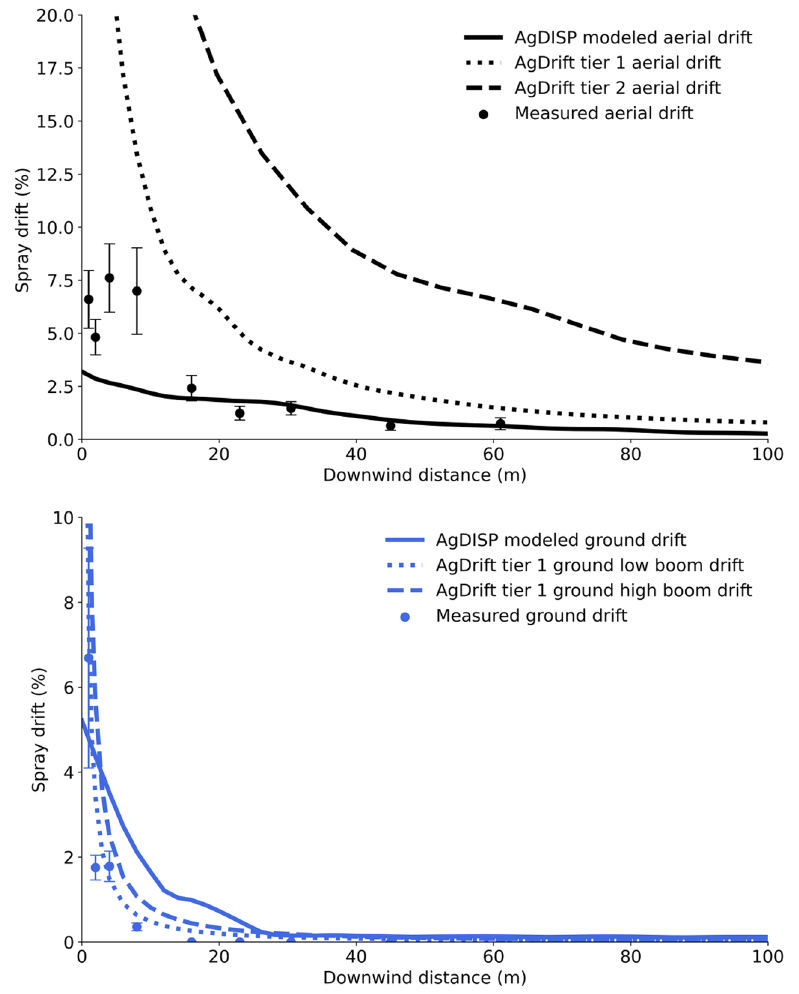
Figure 5. Comparisons of AgDRIFT and AgDISP modeling results to measured data from ground and aerial field trials. Field measured data are presented as the mean percent of application rate at each sampling location with vertical bars as the standard